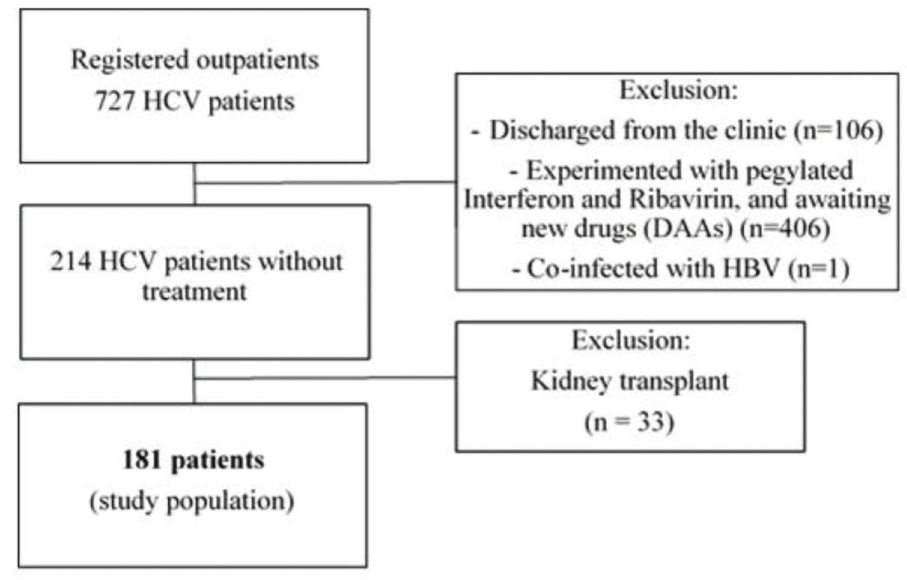
Figure 1 - Flowchart of recruitment of patients. HCV, hepatitis C virus; DAA, direct-acting antiviral; HBV, hepatitis B virus.